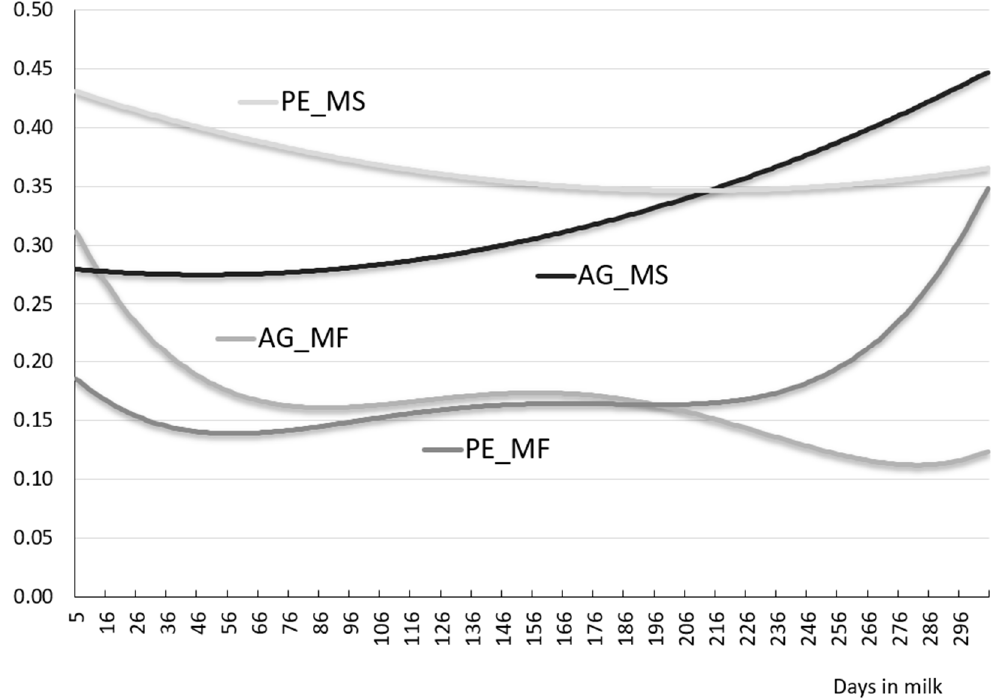
Figure 2. Genetic (AG), permanent environmental (PE) variances for milking frequency (MF) and milking speed (MS) of primiparous cows.